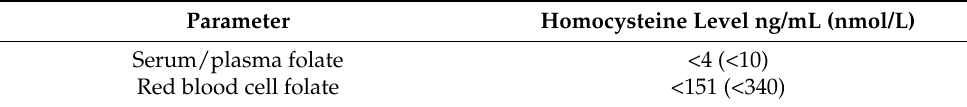
Table 4. Thresholds for determining folate deficiency using homocysteine concentrations as an indicator